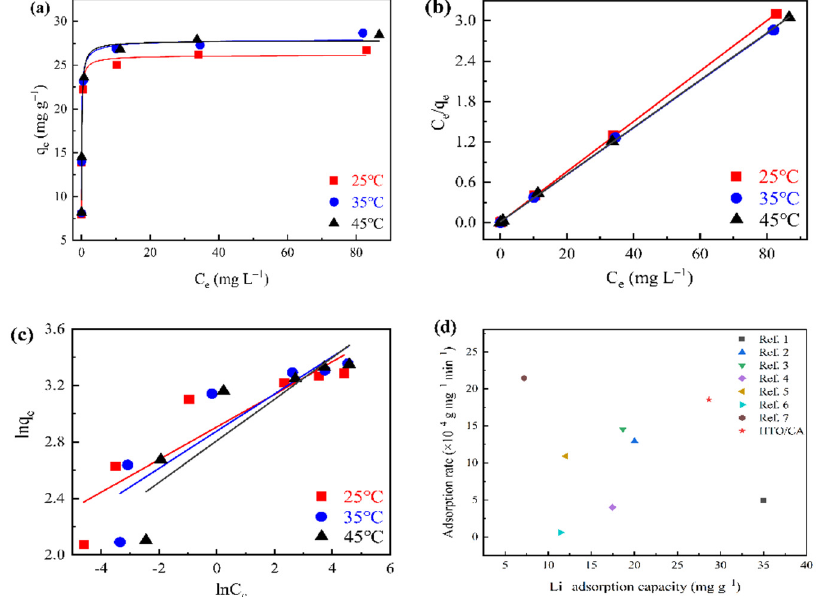
Figure 8. ( a ) Adsorption isotherms, and ( b ) Langmuir and ( c ) Freundlich isotherms of Li + adsorp- tion by HTO/CA at 25 °C, 35 °C, and 45 °C (pH = 10.25; V = 160 mL; m ≅ 100 mg; C 0 = [Li + ] ≅ 5–100 mg L − 1 ). ( d ) Comparison of the Li + adsorption performance of HTO/CA with that of other Li-ion sieve composites [7,14,28,31,42,52,54].